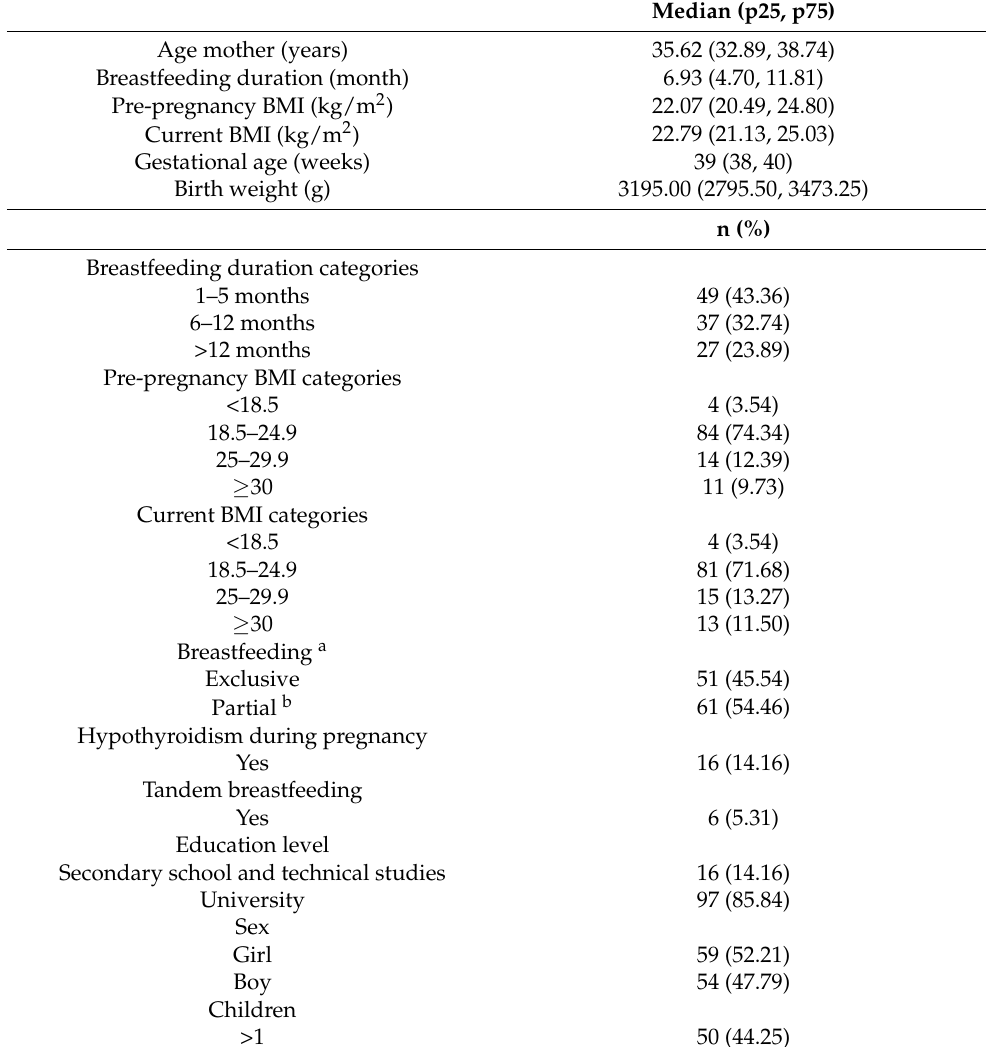
Table 1. Baseline characteristics of human milk donors (n = 113) and their breastfed